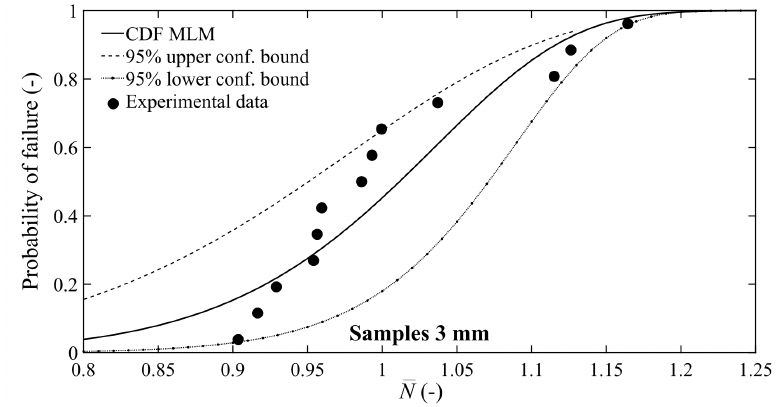
Figure 10. CDF for the specimens of 3 mm in